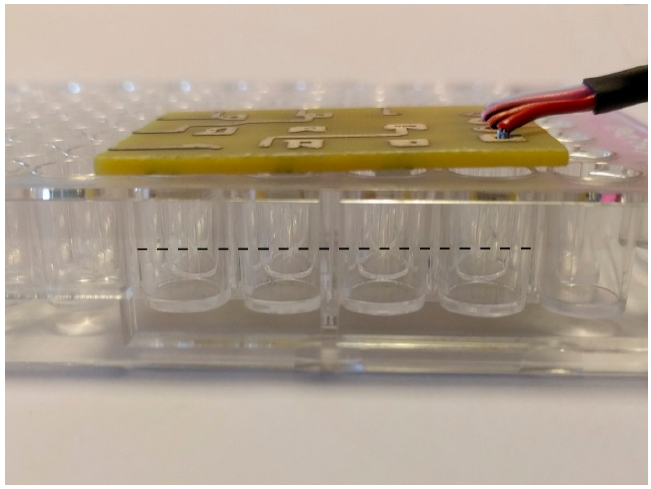
Figure 8. Photograph showing the LED array above microwell